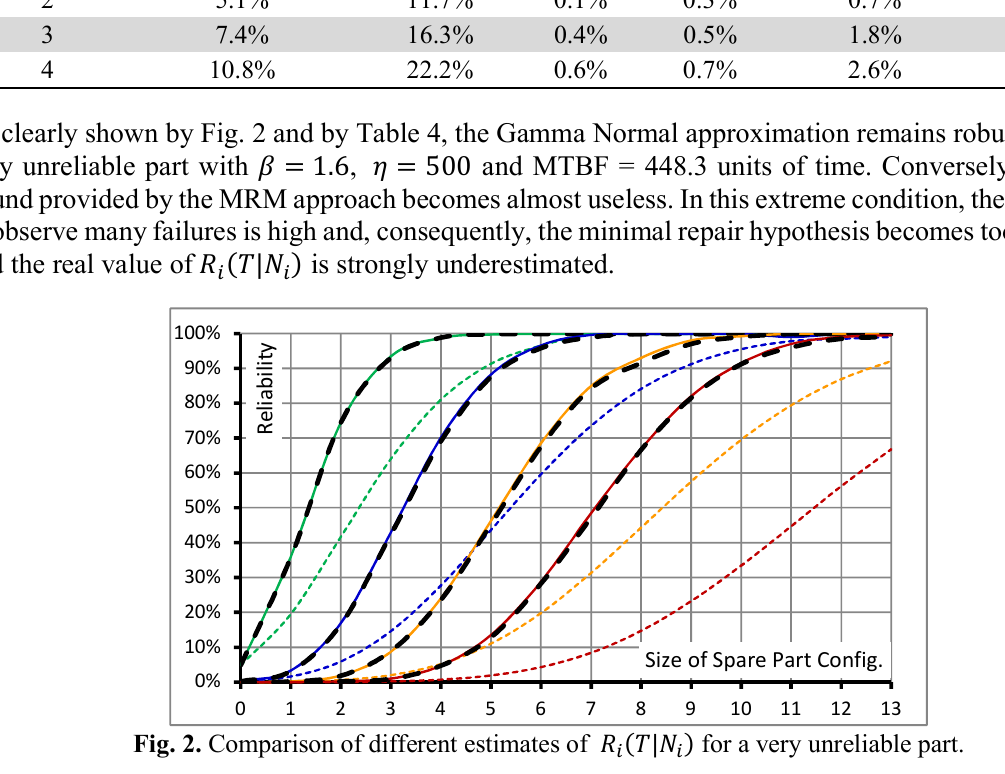
Fig. 2. Comparison of different estimates of 𝑅